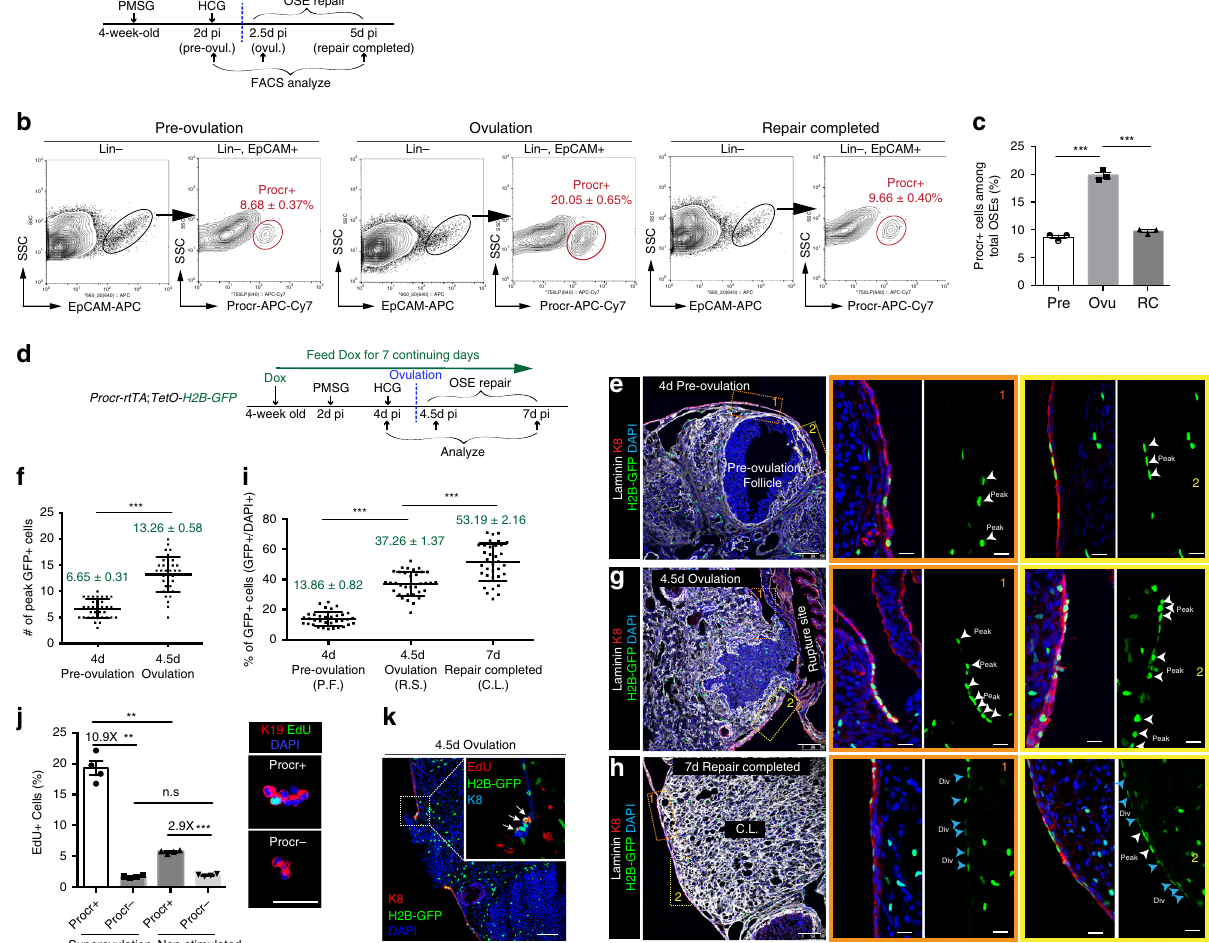
Fig. 3 Procr + cells expand immediately upon ovulation. a Illustration of superovulation and analysis strategy as indicated using wildtype mice. b , c FACS analysis ( b ) and quanti fi cation ( c ) of the percentage of Procr + OSE cells at three different stages as indicated. n = 3 mice. One-way ANOVA with Tukey test is used for comparison of multiple groups. *** p < 0.001. d Illustration of the visualization and tracing strategy for Procr + cells using Procr-rtTA;TetO- H2B-GFP mice. e , f At 4 days after Dox feeding (pre-ovulation), confocal images showing peak level of nuclear GFP + cells in the OSE close to pre-ovulation follicle. Scale bars, 100 μ m. n = 3 mice and 15 images. More than 30 pre-ovulation follicles were scored. f , g At 4.5d pi (ovulation), confocal images showing increasing numbers of peak levels of nuclear GFP + cells in the OSE on both edges of the rupture. Scale bars, 100 μ m. n = 3 mice and 15